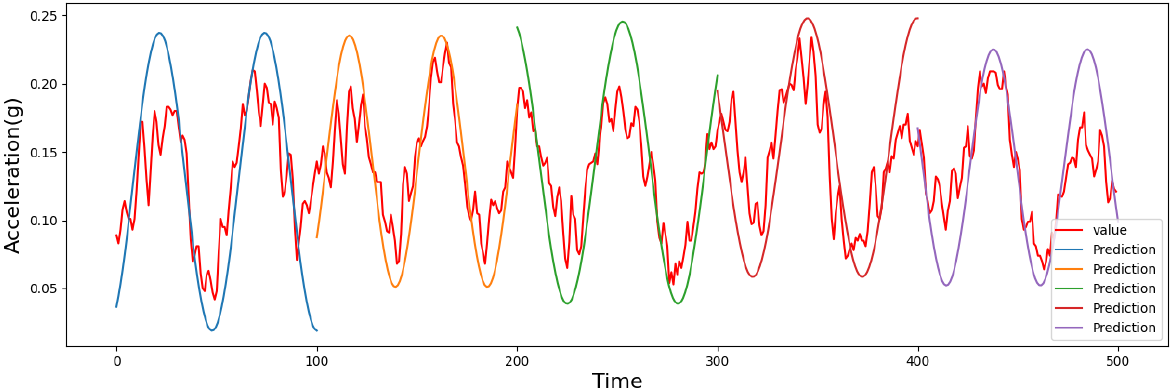
Figure 10. Structural state trend forecasting separated by half a year at different structure status.